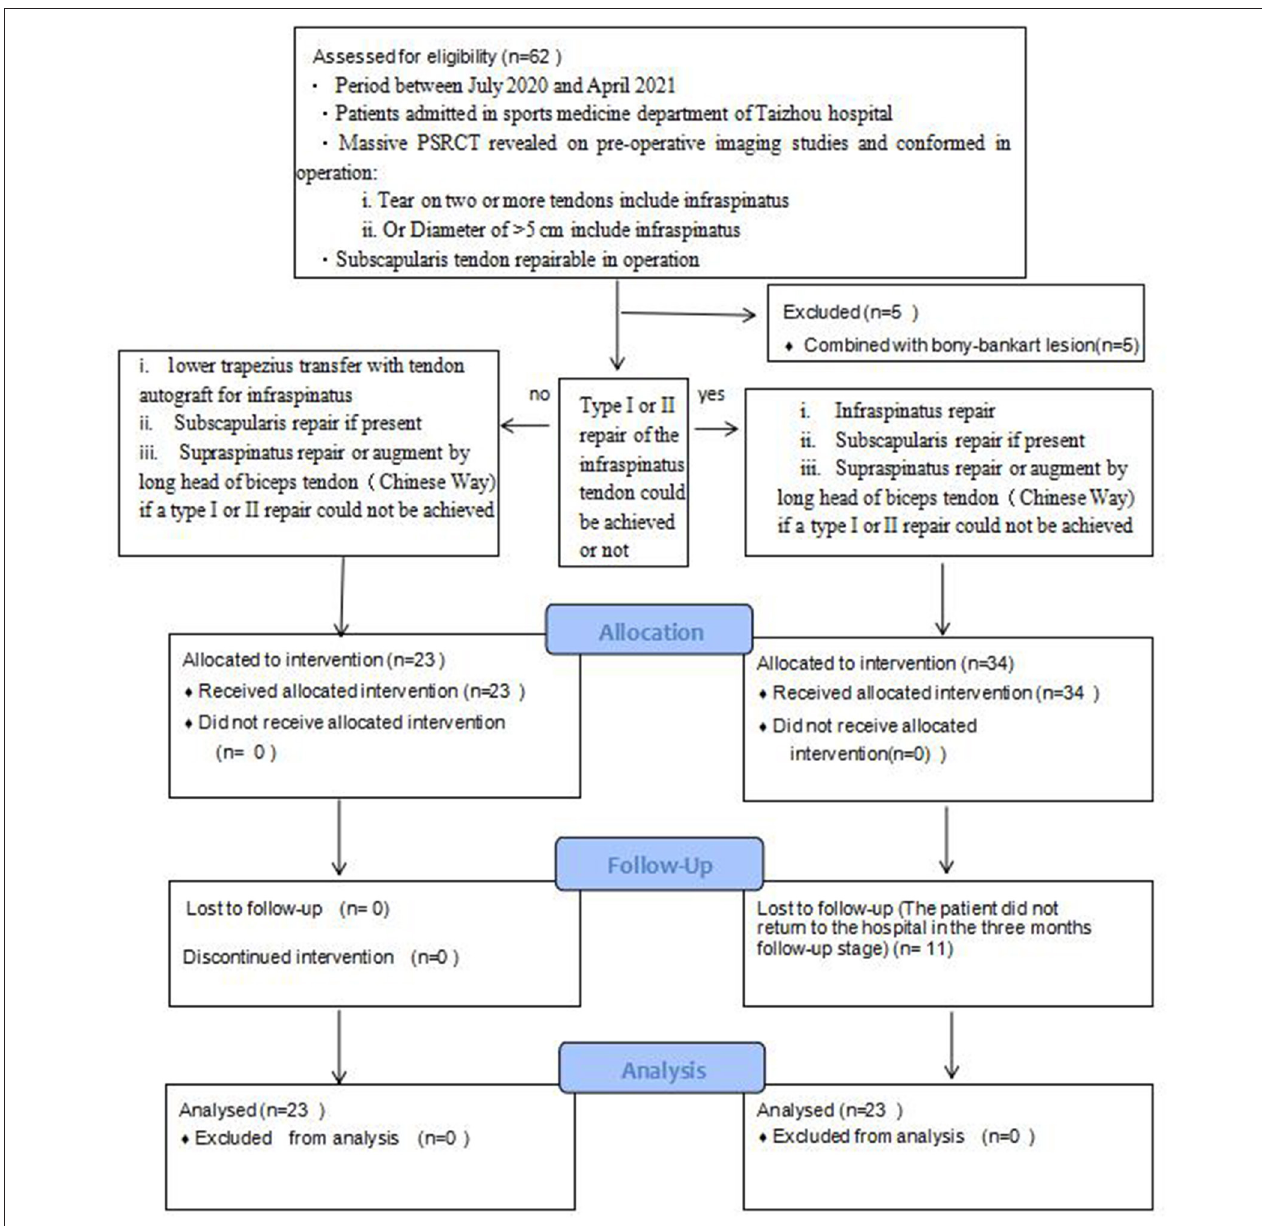
FIGURE 1 | Flowchart showing patient inclusion and